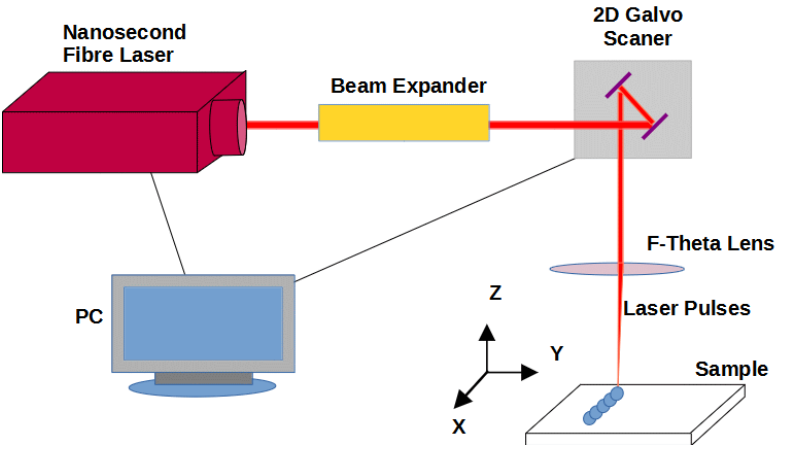
Figure 4. Diagram of the apparatuses used for laser